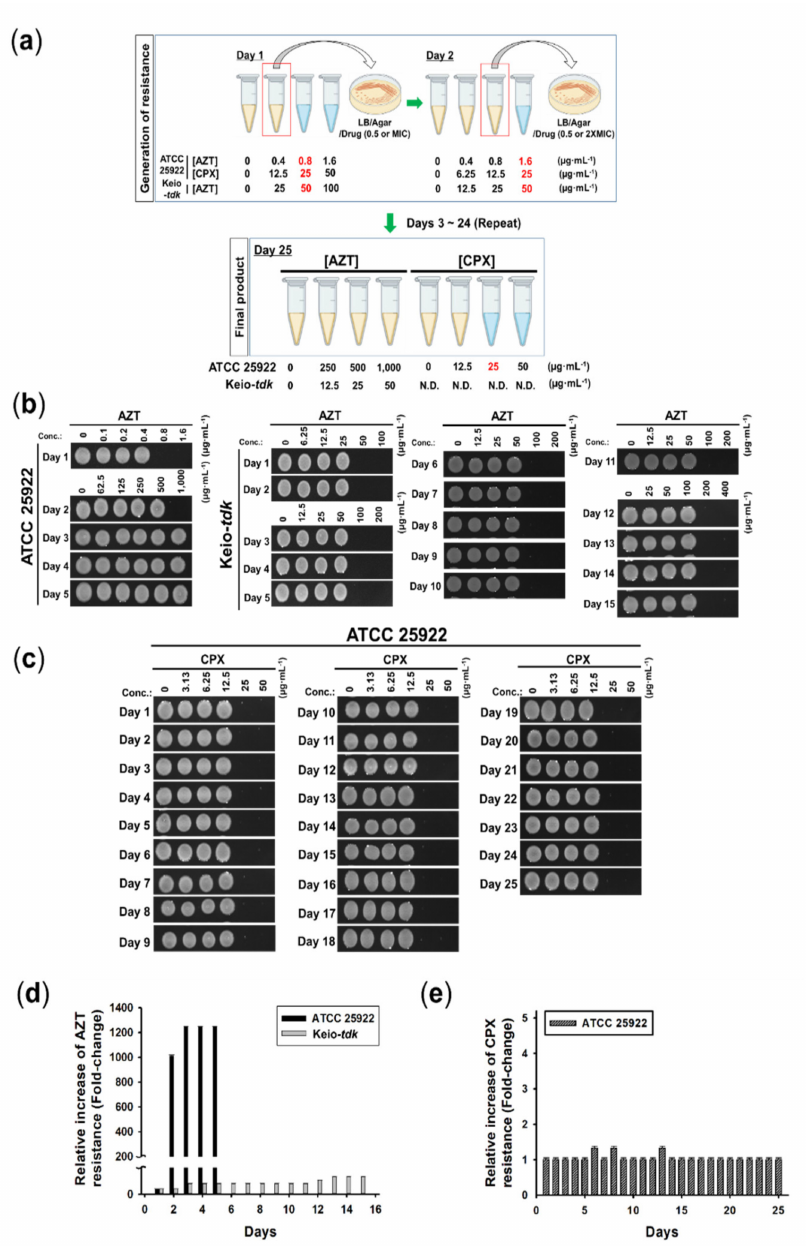
Figure 2. Generation of resistance phenotypes by AZT or CPX. ( a ) Schematic representation of the resistance generation method. Bactericidal activity of ( b ) AZT or ( c ) CPX against E. coli ATCC 25922. Representative data from n = 3 experiments, as described in Section 3.4 are shown. Relative increase of resistance of ATCC 25922 to ( d ) AZT or ( e ) CPX. The relative increase of resistance as a fold change with respect to non-drug-treated ATCC 25922 or Keio- tdk cells (set to 1 for each set) was calculated based on MIC changes from ( b , c ). The values shown in the graph at the indicated days are averaged values from n = 3 experiments, with standard deviations ( p <